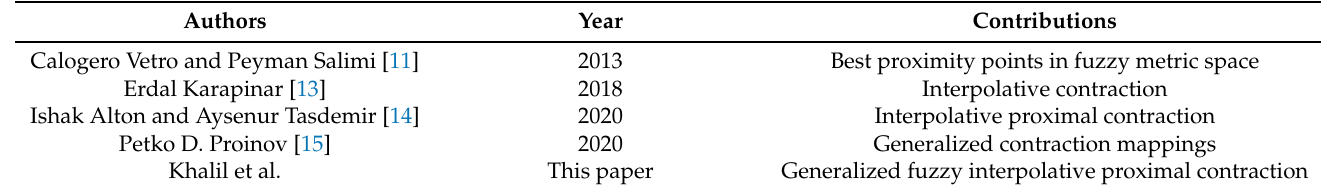
Table 1. Contributions of several authors towards generalized interpolative proximal